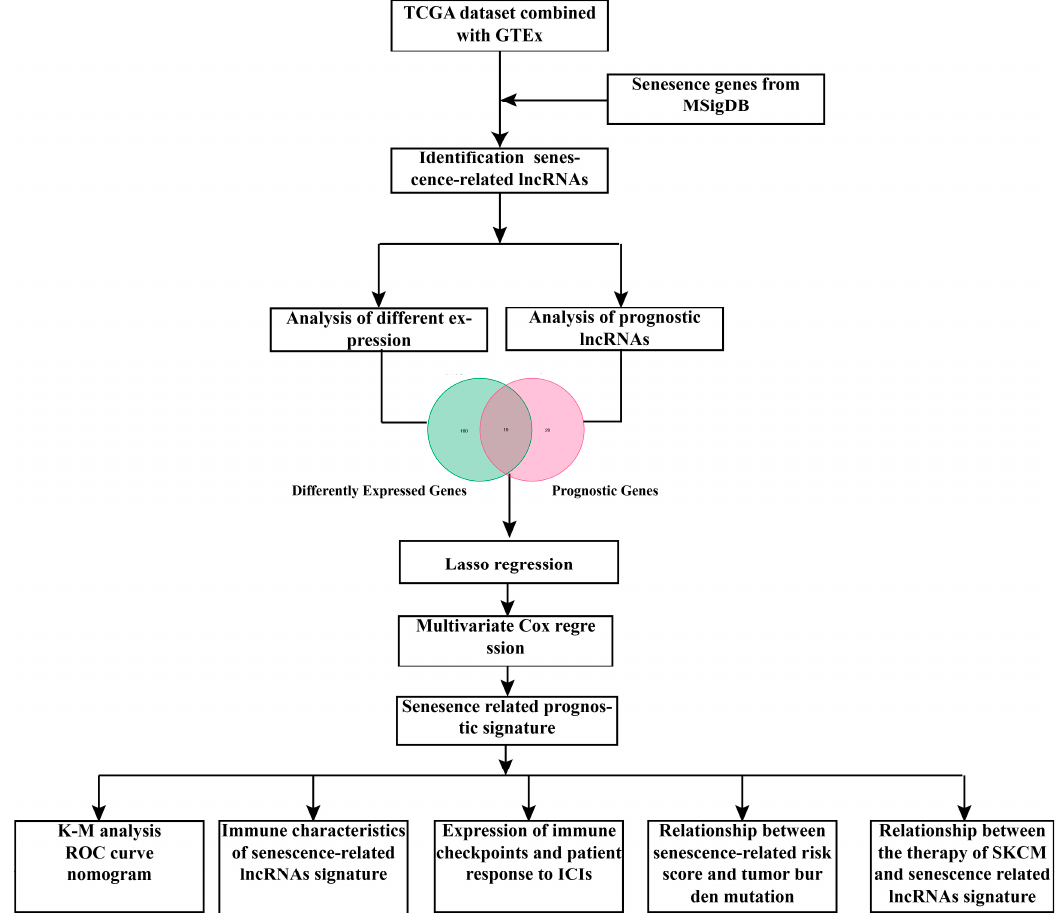
Figure 1. Process fl owchart for analysis. TCGA, the Cancer Genome Atlas; GTEx: the Genotype Tissue Expression data- base. MSigDB: the Molecular Signatures Database. lncRNAs: long non-coding RNAs; K-M analysis: Kaplan–Meier ap- proach for survival analysis. ROC curve: the receiver operating characteristic curve. ICIs: immune checkpoint inhibitors. SKCM: skin cutaneous